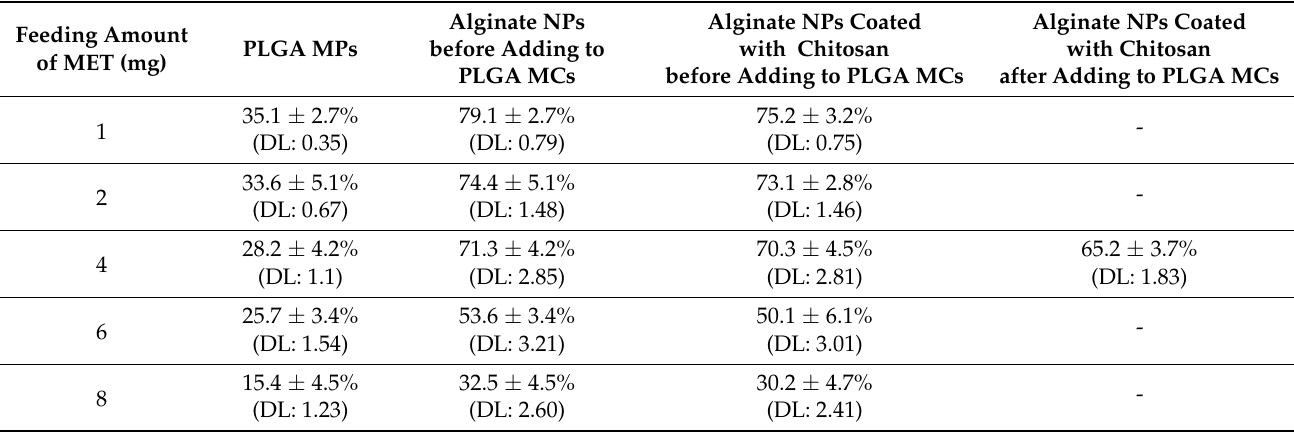
Table 1. Encapsulation efficiency (EE) and drug loading (DL) before and after loading NPs in microparticles (MPs) ( n = 3, mean ± SD).